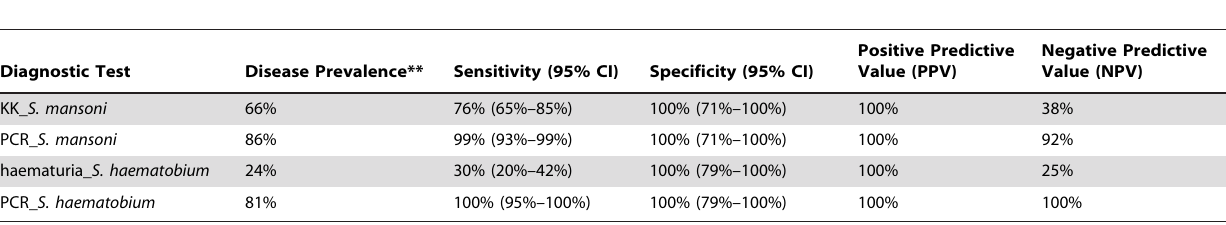
Table 2. Estimation of disease prevalence, sensitivity, specificity, predictive values and likelihood ratios byPCR against standard parasitological tests* for current study for identifying mixed schistosome infection from